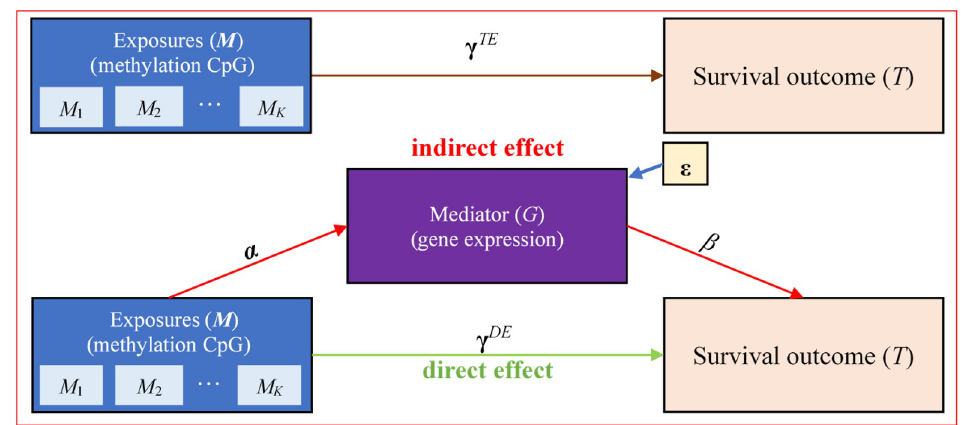
Fig 1. Statistical framework of the survival mediation analysis with multiple exposures, one mediator and one censored outcome. The mediation analysis involves in multiple DNA methylations ( M ) as exposures, one gene expression ( G ) as the mediator and one survival time as the outcome ( T ). There are two types of effects from M to T : the direct effect of M on T (i.e., γ DE ) and the indirect effect of M on T via the intermediate variable G . The indirect effect represents the amount of mediation coming from two sources: the effect from M to G (i.e., α ) and the effect from G to T (i.e., β